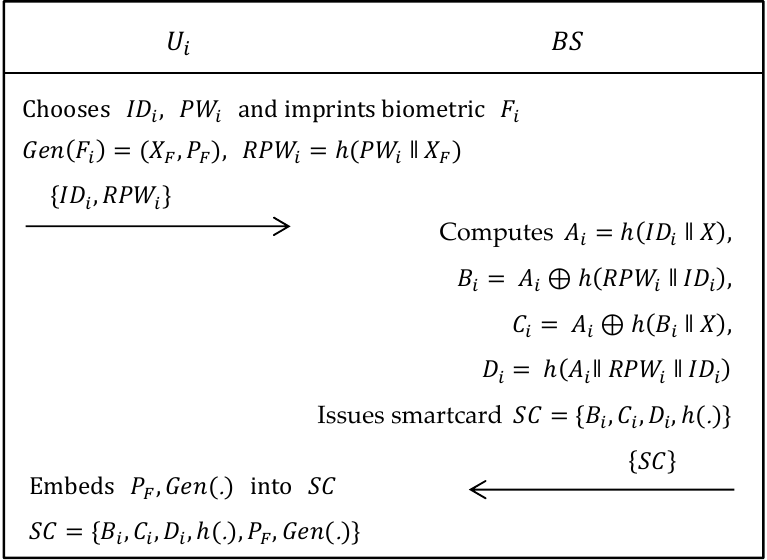
Figure 2. Registration phase of Ali et al.’s scheme.